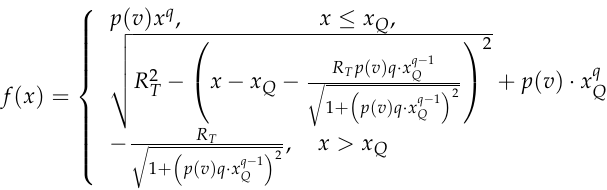
Fig. 5. Turn paths of kinematic center of wheeled